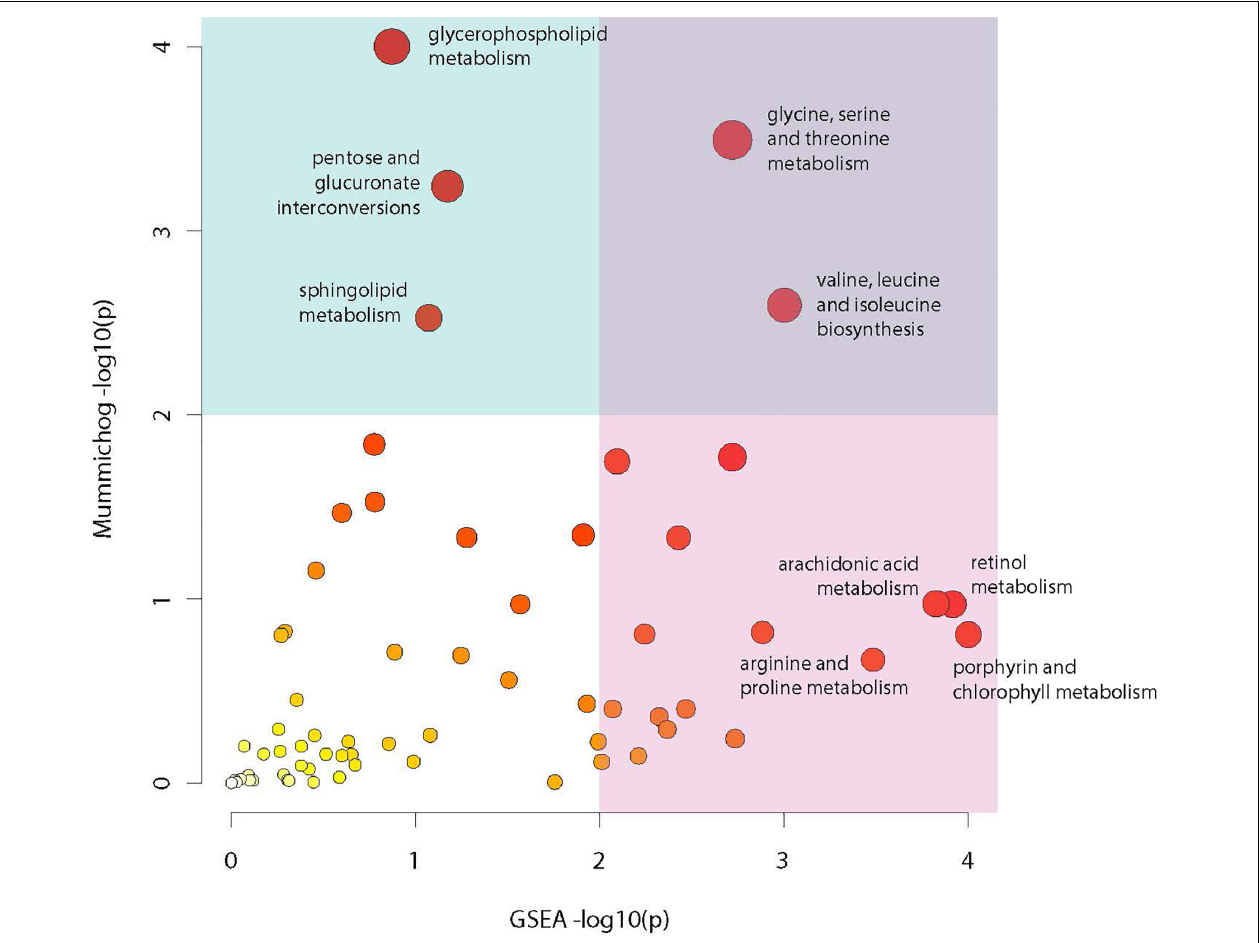
FIGURE 7 | Metabolic pathway enrichment. Visualization of enriched metabolic pathways as identified using the Mummichog pathway analysis package. Analysis utilized raw mz and rt values for LC-MS profiles from the lipidomic and biogenic amine analysis panels in combination with p -values from statistical comparisons between treatment groups to identify pathways with perturbations in compound abundances in infected mosquitoes. The X axis represents − log10 p -value derived from the GSEA (Gene Set Enrichment Analysis) algorithm and the Y axis represents the − log10 p -value derived from the Mummichog enrichment analysis algorithm. Size and color of dots represents